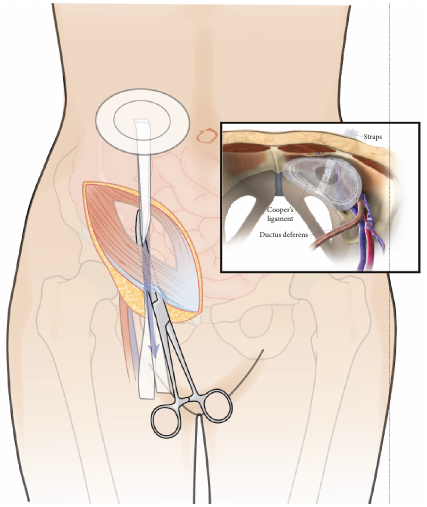
Figure 3: Ventralex ™ Hernia Patch is pulled through the femoral ring and obliterates the entire myopectineal ori fi ce from